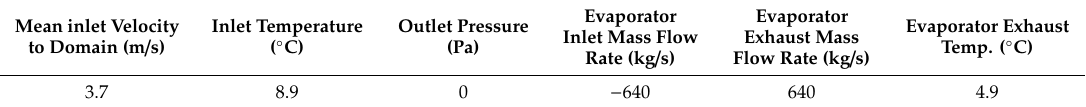
Table 2. Boundary conditions of the CFD